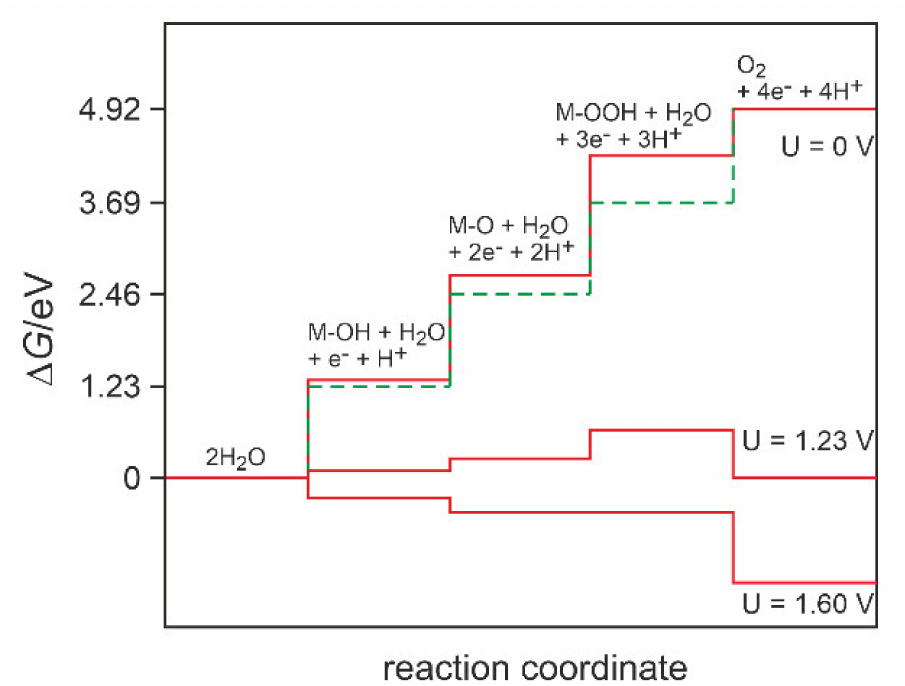
Figure 1. Energetics of OER over RuO 2 . Red, solid lines depict the Gibbs free energies of the reaction intermediates at three different external potentials U = 0 V, U = 1.23 V, and U = 1.60 V. Only at 1.60 V are all the reaction steps thermodynamically favorable. Green, dashed line depicts the ideal 1.23 V barrier for all of the reaction steps. Figure adapted from